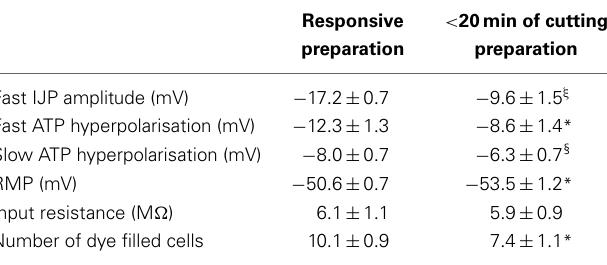
Table 1 | The effects of re-cutting a preparation after recovery from